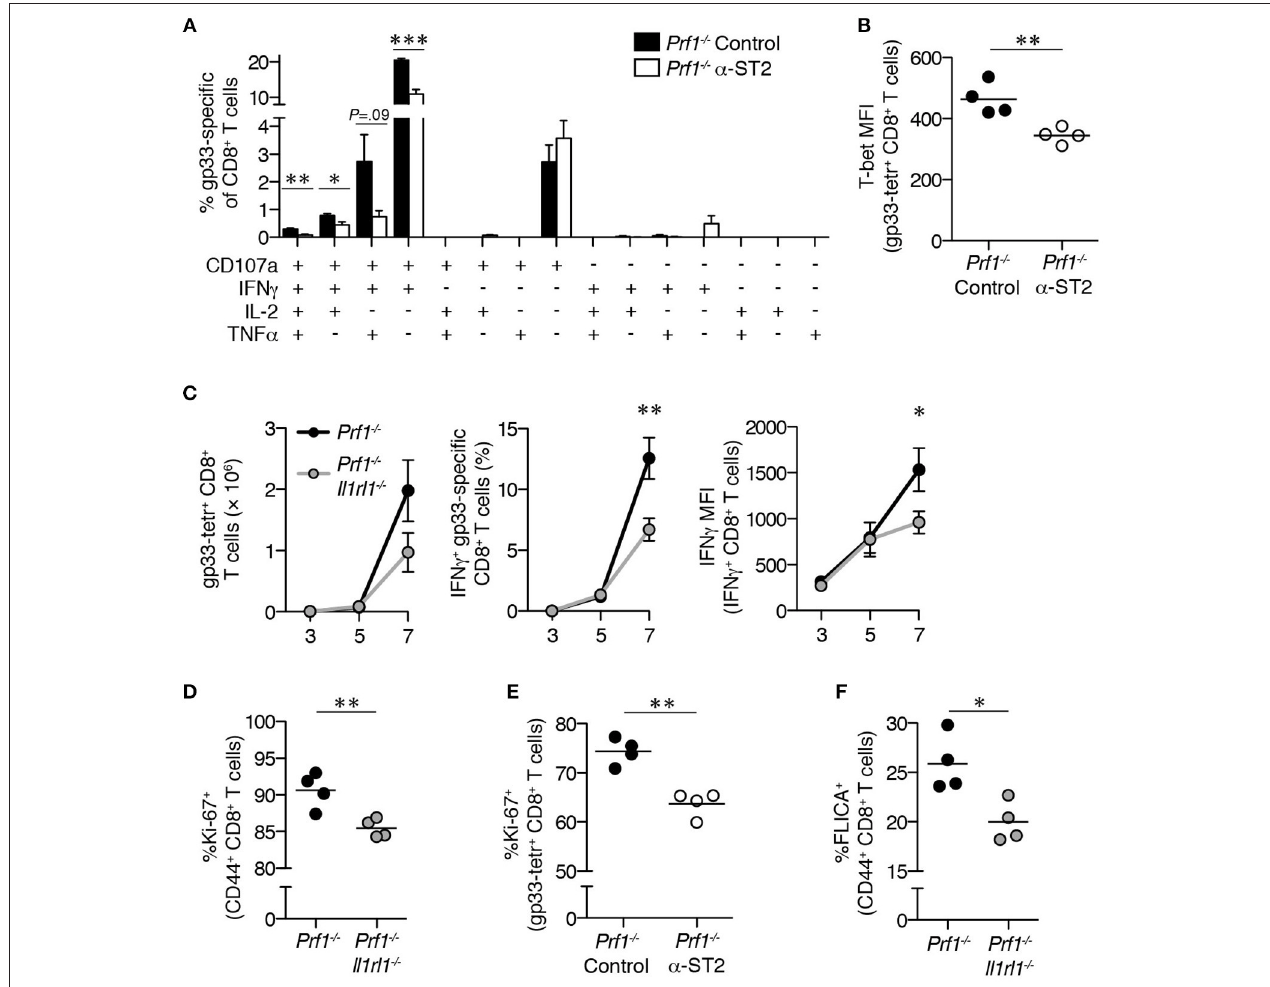
FIGURE 5 | Prf1 − / − CD8 + T cells demonstrate early global defects in effector function in the absence of ST2 signaling. LCMV-infected Prf1 − / − mice were treated with either isotype control antibody ( Prf1 − / − Control, shown in black bars/symbols) or ST2-blocking antibody ( Prf1 − / − α -ST2, shown in white bars/symbols) and splenocytes were analyzed 8 days p.i. N = 4 mice/group. Analyzed by Student’s two-tailed t -test. (A) Frequency of CD8 + T cells externalizing CD107a and/or producing IFN γ , IL-2, and/or TNF α in response to gp33 peptide (above background). (B) T-bet MFI in gp33 tetramer + CD8 + T cells. (C) Total numbers of splenic gp33-tetramer + CD8 + T cells (left panel), frequencies of IFN γ + gp33-specific CD8 + T cells (middle panel), and median IFN γ fluorescence intensity of IFN γ + CD8 + T cells (right panel) from LCMV-infected Prf1 − / − and Prf1 − / − Il1rl1 − / − mice analyzed over time. Symbols represent mean ± SEM of n = 3–8 mice/timepoint/genotype. Data are pooled from 2 independent experiments. Day 7 timepoint analyzed by Student’s two-tailed t -test. (D) Frequencies of Ki-67 + cells among Prf1 − / − or Prf1 − / − Il1rl1 − / − CD44 + CD8 + T cells. N = 4 mice/genotype. Analyzed at day 7 p.i. by Student’s two-tailed t -test. (E) Frequencies of Ki-67 + gp33 tetramer + CD8 + T cells from LCMV-infected Prf1 − / − mice treated with either isotype control antibody ( Prf1 − / − Control) or ST2-blocking antibody ( Prf1 − / − α -ST2). N = 4 mice/genotype. Analyzed at day 8 p.i. by Student’s two-tailed t -test. (F) Frequencies of Prf1 − / − or Prf1 − / − Il1rl1 − / − CD44 + CD8 + T cells staining positively with fluorescent inhibitor of caspases 3 and 7 (FLICA). N = 4 mice/genotype. Analyzed at day 7 p.i. by Student’s two-tailed t